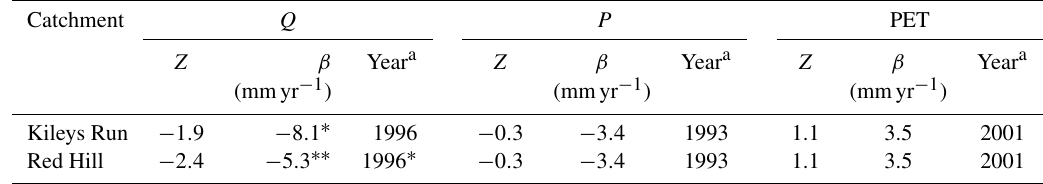
Table 1. Estimated trends and abrupt change points in annual runoff ( Q ), precipitation ( P ), and potential evapotranspiration (PET) of the Red Hill and Kileys Run catchments, New South Wales, Australia, during the period of 1990–2015. Catchment